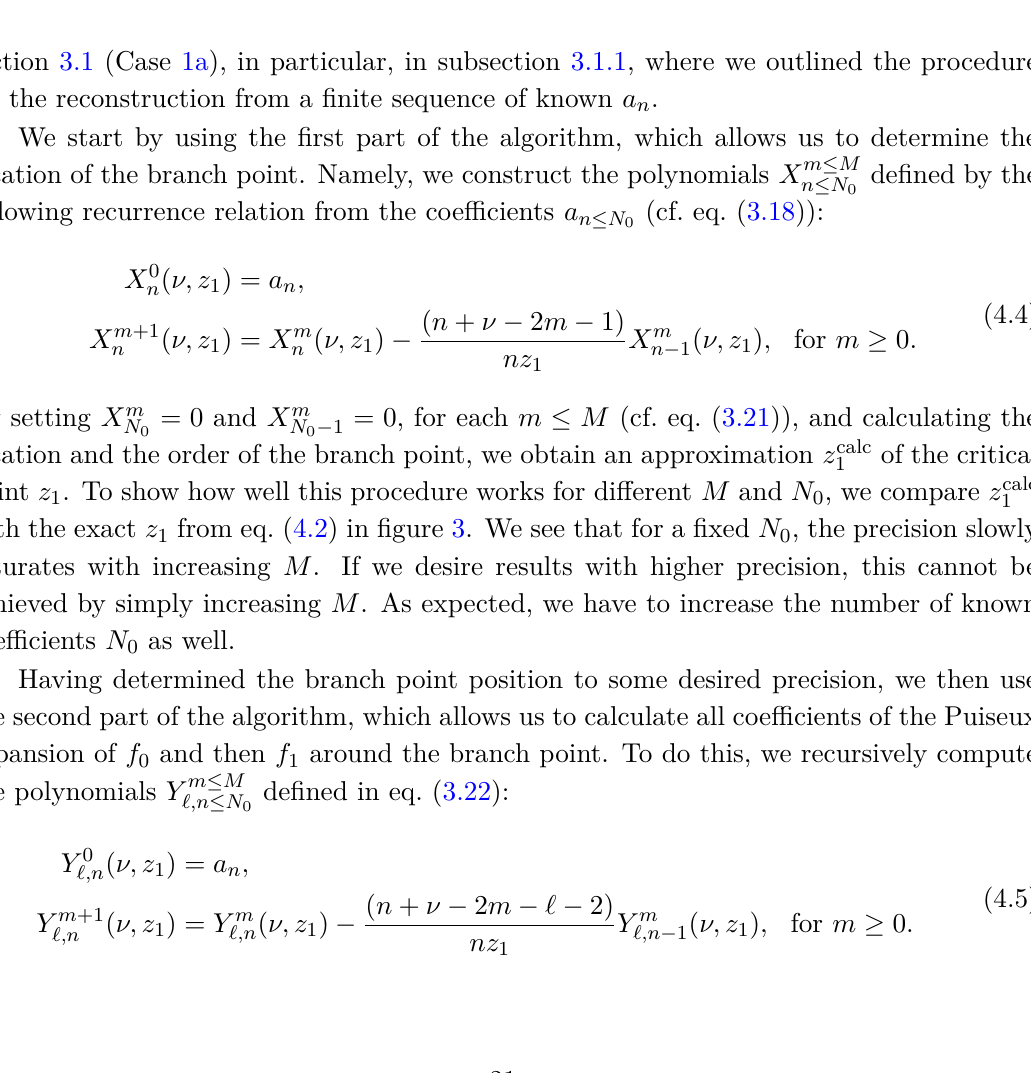
Figure 3. Error in the calculated branch point position plotted as a logarithm of | z calc different values of M , and a choice of three different values of N 0 = 100 (in blue), N 0 = 500 (in orange) and N 0 = 2000 (in